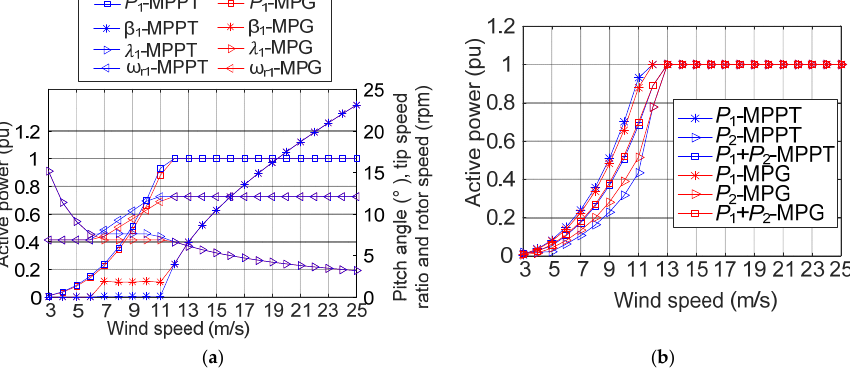
Figure 9. Comparison between the MPPT control and MPG control at the wind direction of 270°: ( a ) pitch angle, tip speed ratio, rotor speed, and active power of WT 1 ; ( b ) active power of WT 1 , active power of WT 2 , and the total active power of the wind farm.